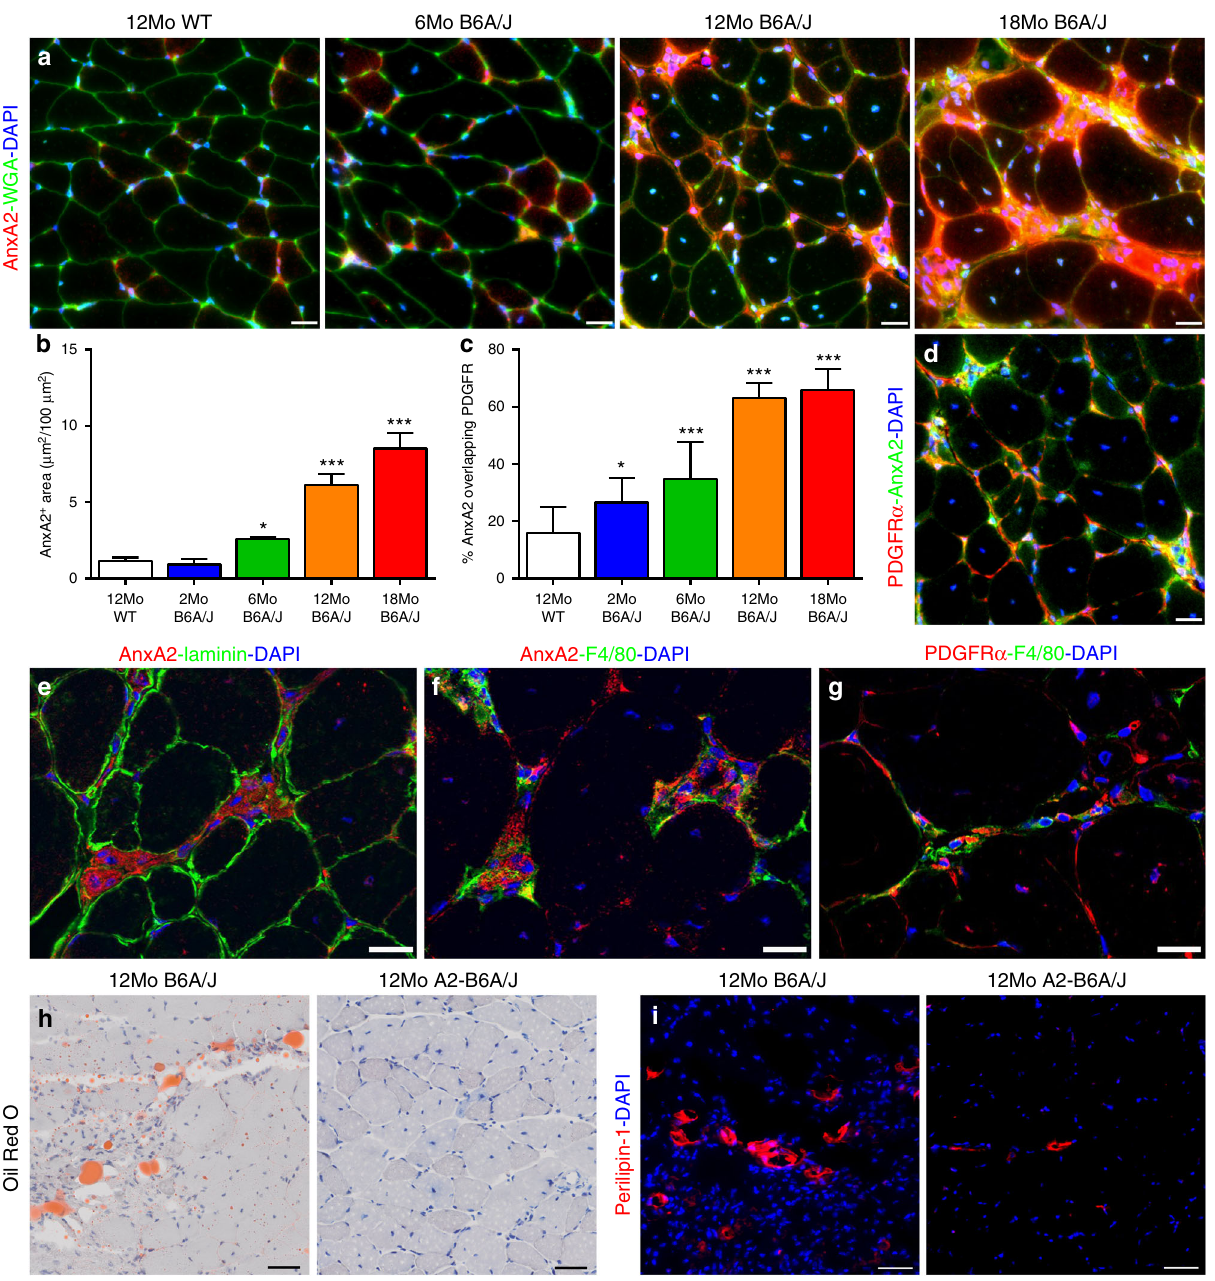
Fig. 4 Extracellular accumulation of AnxA2 drives FAP accumulation in dysferlinopathic muscle. a AnxA2 staining in cross-sections from 6, 12, and 18Mo B6A/J and 12Mo WT mouse gastrocnemius muscle. Scale bar = 20 µ m. b Quanti fi cation (mean ± SD) of total AnxA2-labeled area across the entire muscle cross-section, n = 4 mice/group. Statistical comparisons performed via ANOVA with Holm – Sidak multiple comparisons test to compare all means with 12Mo WT, * p < 0.05, ** p < 0.01, *** p < 0.001. c Quanti fi cation (mean ± SD) of d co-localization between AnxA2 and PDGFR α in 12Mo B6A/J gastrocnemius, n = 4 mice/group. Statistical comparisons performed via ANOVA with Holm – Sidak multiple comparisons test to compare all means